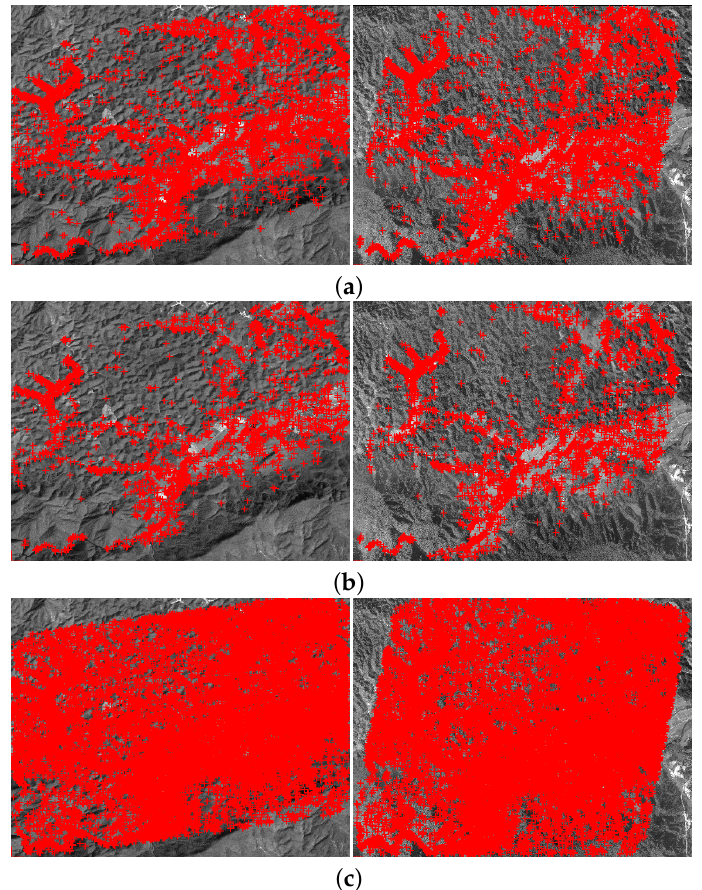
Figure 16. Comparison of the matching results produced by the three methods: ( a ) the matching result produced by TAACC; ( b ) the matching result produced by GC 3 ; ( c ) the matching result produced by the proposed